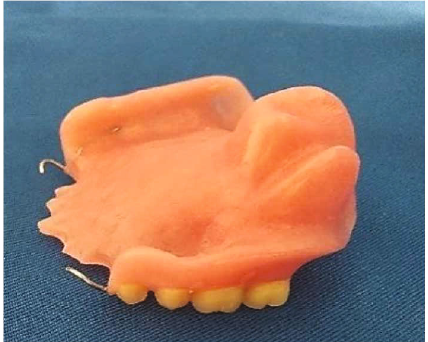
Figure 10: Obturator